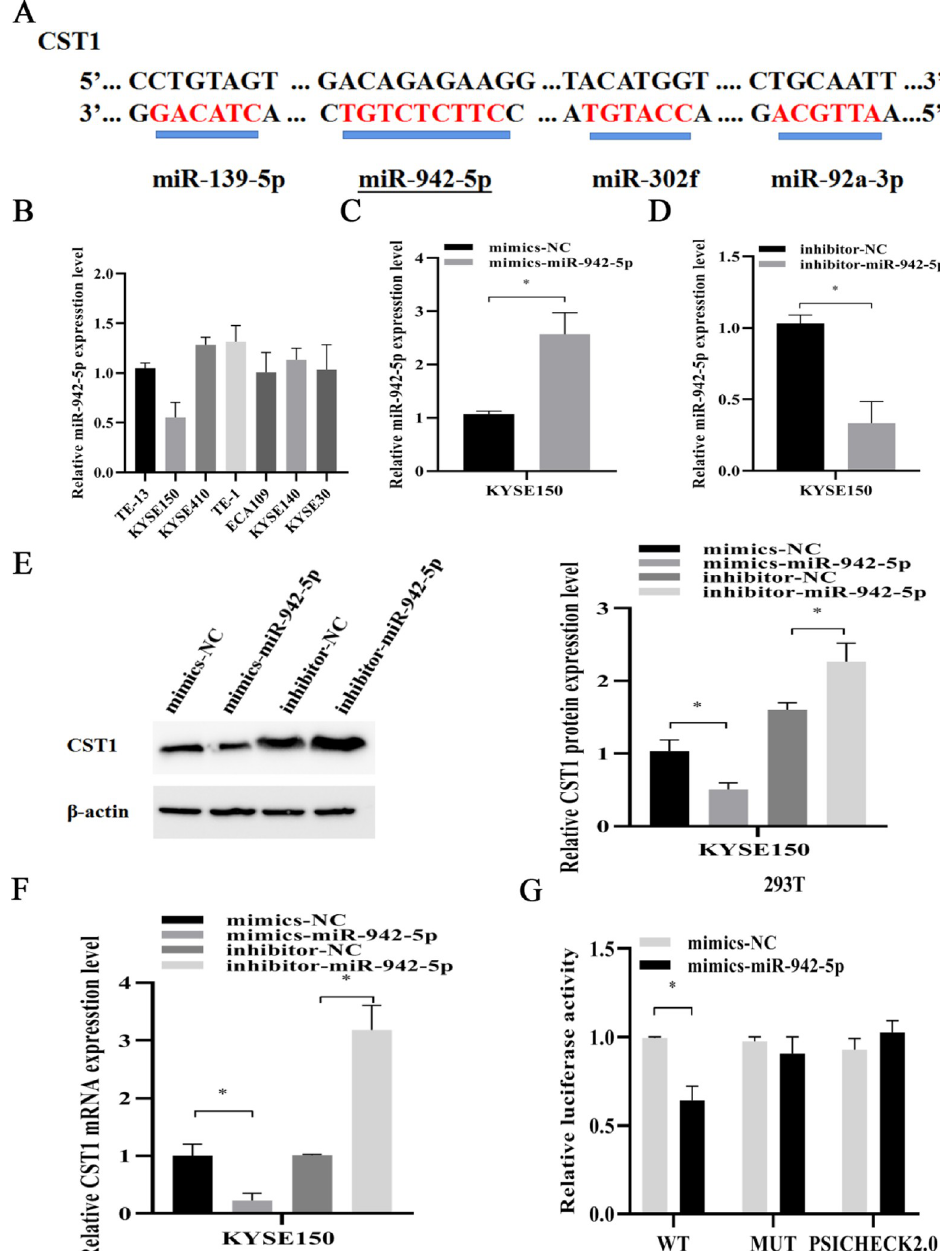
Fig 6. MiR-942-5p regulates the expression of CST1. (A) Conserved binding sites of four miRNAs to CST1 sequences. (B) Expression of miR-942-5p in 7 cell lines. (C) Expression of miR-942-5p after transfection of mimics. (D) Expression of miR-942-5p after transfection of inhibitor. (E) Effect of miR-942-5p on CST1 protein levels. (F) Effect of miR-942-5p on CST1 mRNA levels. (G) Dual luciferase assay demonstrated the regulation of CST1 by miR- 942-5p. ( � P < 0.05, �� P <